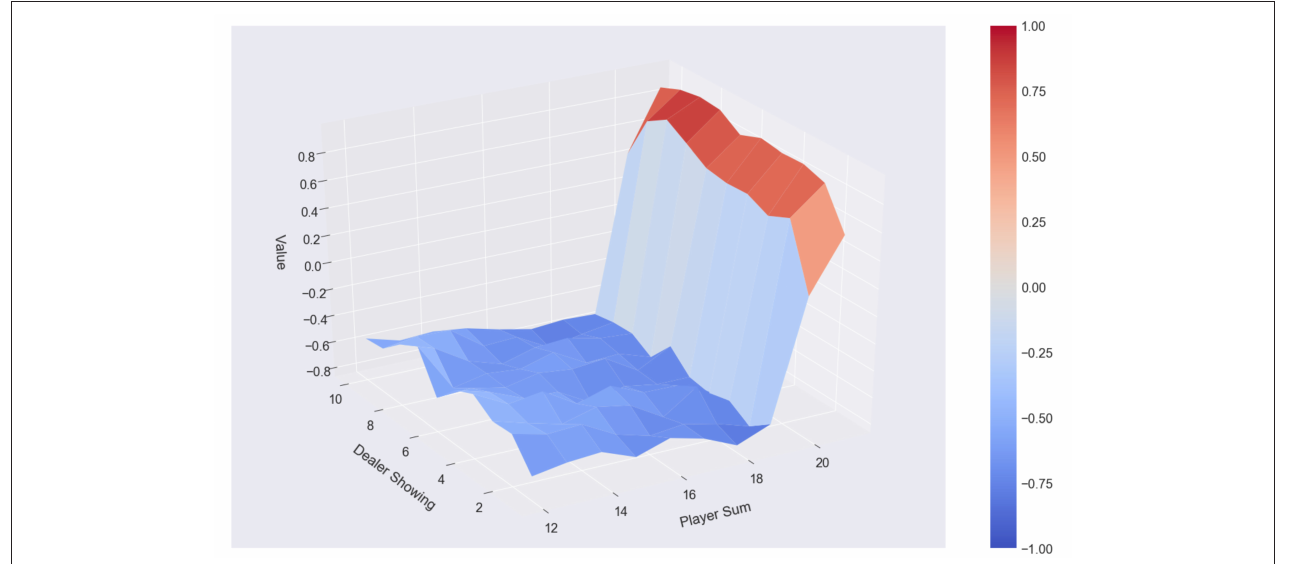
FIGURE 7 | Quantum-enhanced Monte Carlo: 500 episodes, 7 policies, policy α , averaging over results, no usable ace.